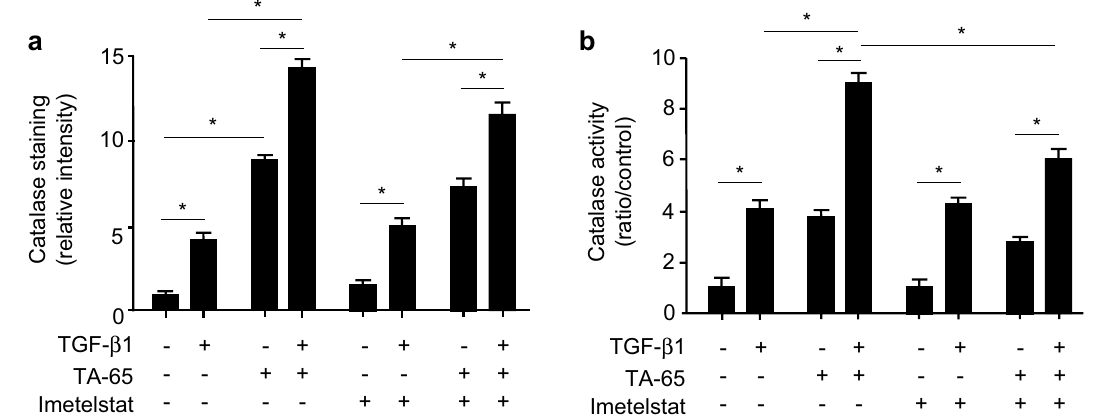
Figure 6. Effects of TA-65, Imetelstat and TGF-β1 on catalase in vitro. MEF cells were pre-treated with TA-65 (2 µM) and/or Imetelstat (1 µM) during 24 h, followed by TGF-β treatment (10 ng/mL) for 48 h. Catalase expression was evaluated by immunostaining ( a ). Representative images are available in Supplementary Fig. S4. Catalase activity of cell lysates was quantified using an Amplex Red Catalase Assay kit ( b ). n = 4 samples per group. Data are presented as mean ± SEM. *p <